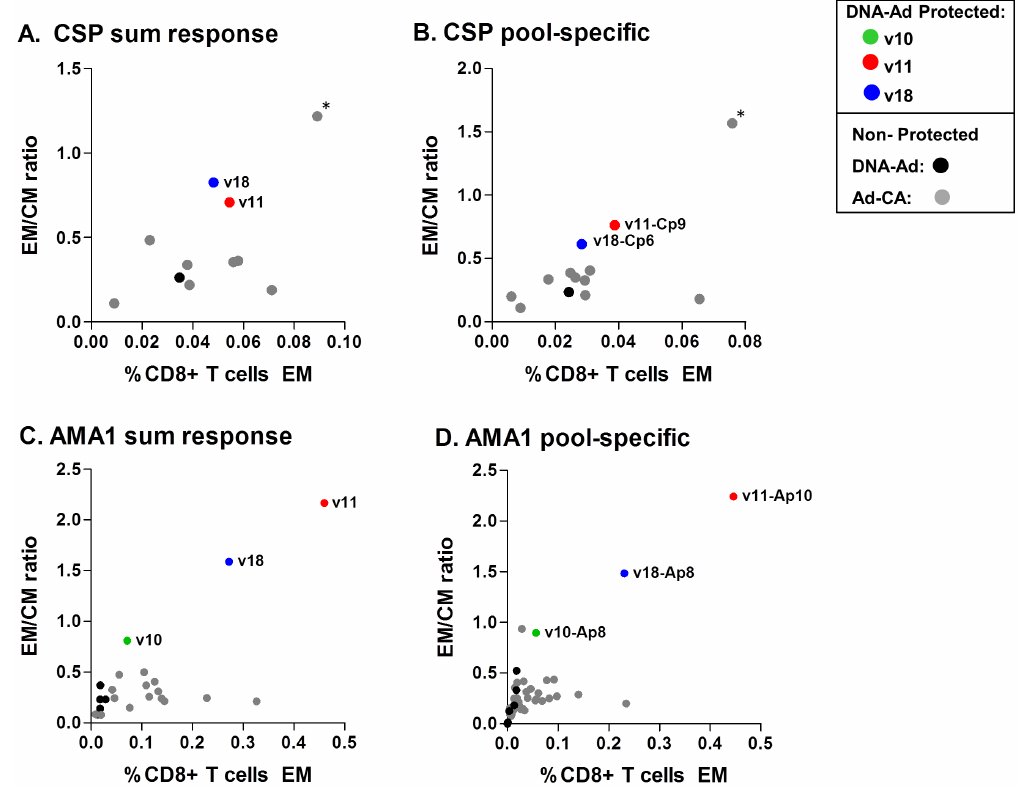
Figure 6. Ratios of effector to central memory in DNA/Ad and AdCA trials for CSP and AMA1 (based on summed and pool-specific responses). All volunteers who had positive summed and pool-specific CD8 + IFN- c memory central (CM) and effector (EM) activities after Ad boost for CSP or AMA1 were plotted as the ratio of EM:CM vs. EM activity. In addition, some volunteers who had positive CM but negative EM activities were included. Volunteers with negative CM and EM activities were not included. Panel A. CSP summed response: protected v11 and v18 had a higher EM:CM ratio than all other volunteers in the DNA/Ad and AdCA trials, except v135 in the AdCA trial (*). EM activity of v18 did not meet the positivity definition. Panel B. CSP pool-specific response: protected v11 and v18 had a higher EM:CM ratios against Cp9 (v11) and Cp6 (v18) respectively than all other volunteers with positive EM and/or CM activities against any individual pools in the DNA/Ad and AdCA trials, except v135 in the AdCA trial. EM activity of v18 did not meet the positivity definition. Panel C. AMA1 summed response: protected v10, v11, and v18 had a higher EM:CM ratio than all other volunteers with positive EM and/or CM activities in the DNA/Ad and AdCA trials. Panel D. AMA1 pool specific response: protected v10, v11 and v18 had a higher EM:CM ratios against Ap8 (v10 and v18) and Ap10 (v11) compared to all other volunteers in the DNA/Ad and AdCA